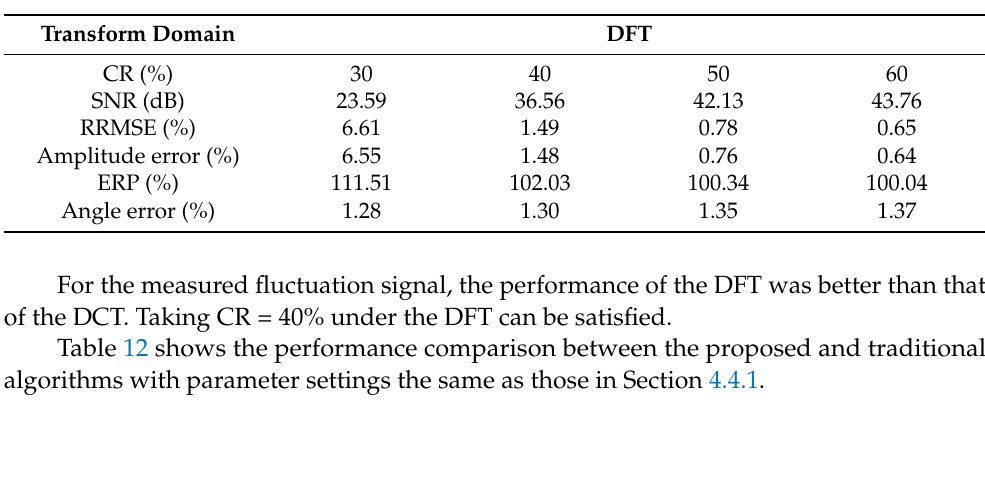
Figure 8. Measured fluctuant signal waveform and its DFT and DCT coefficients. Table 10. Reconstruction results of the fluctuant signal in the DFT domain.